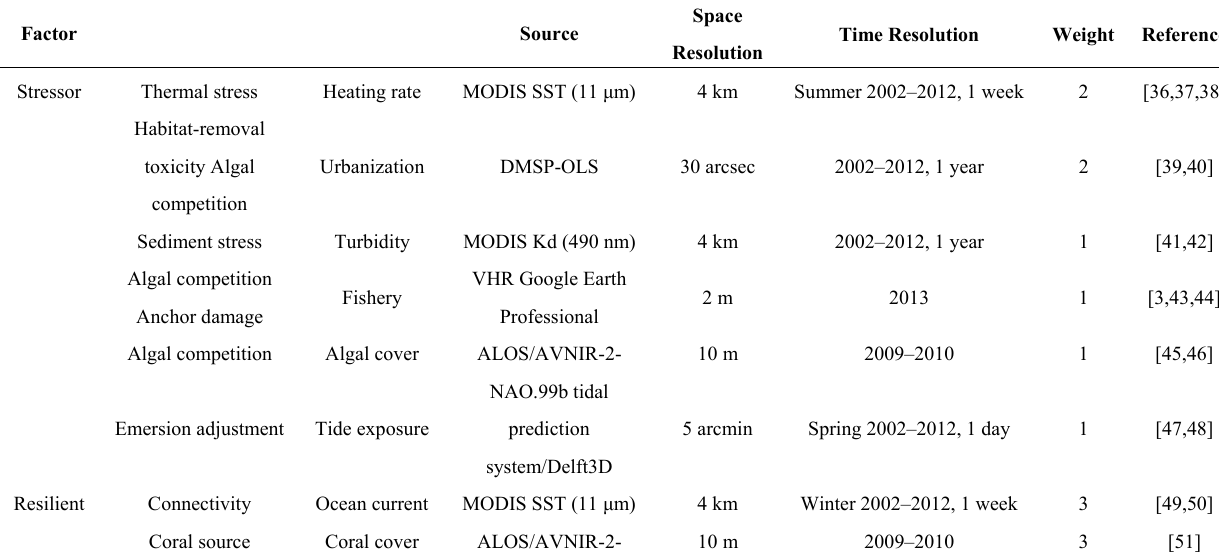
Table 2. Ecological stress and resilience exogenous factors, space-time data features, weighting and justification of the factors. The justification is based on the main references that link the factor with its relevance to Japanese ecological resilience in relation to coral